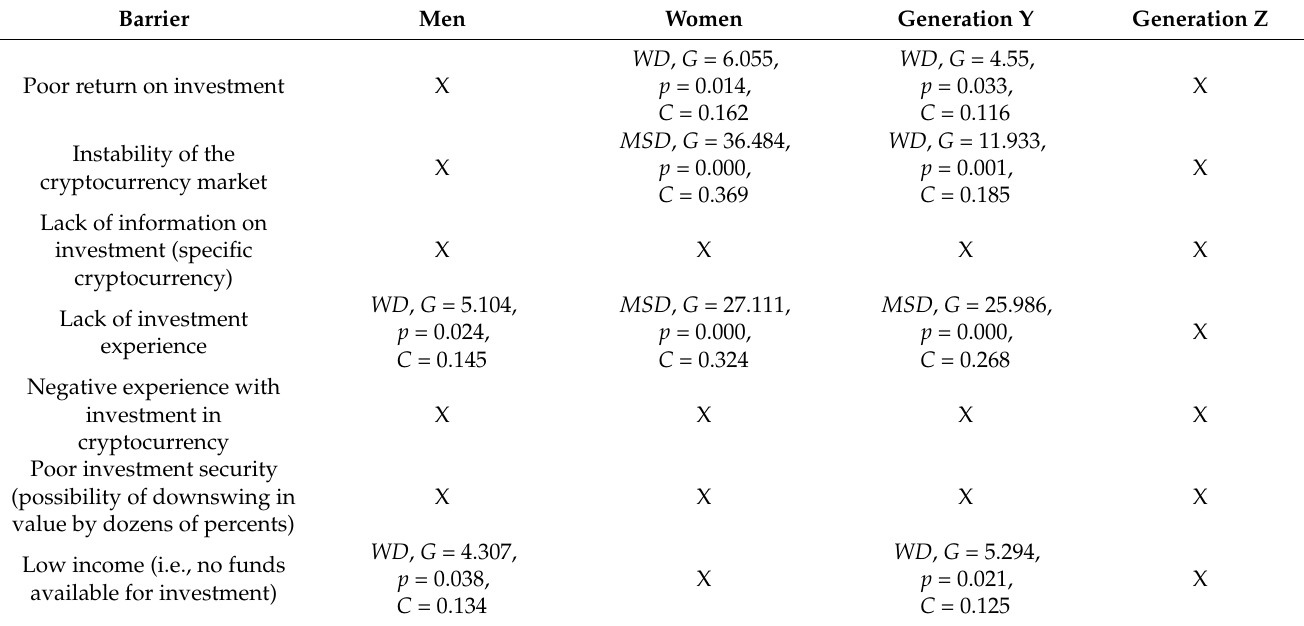
Table 2. The table shows the statistically significant dependence of individual barriers with respect to the tendency to take risks and generations or sex. MSD = moderately strong dependence; WD = weak